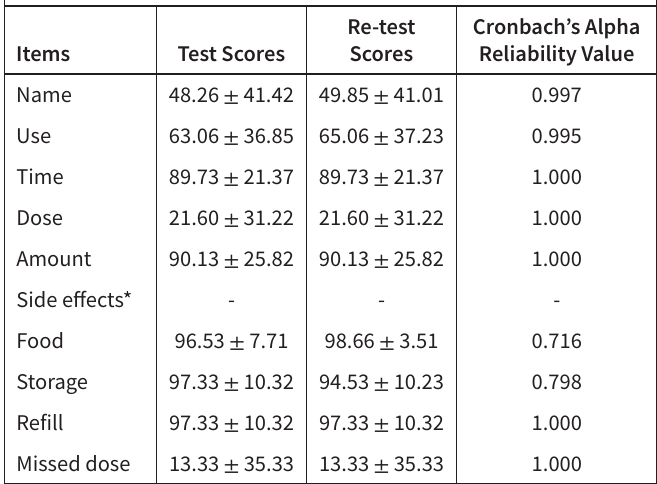
Table 1. Demographics of the HD Patients Table 2. Test–Retest Reliability Results of MKAQ